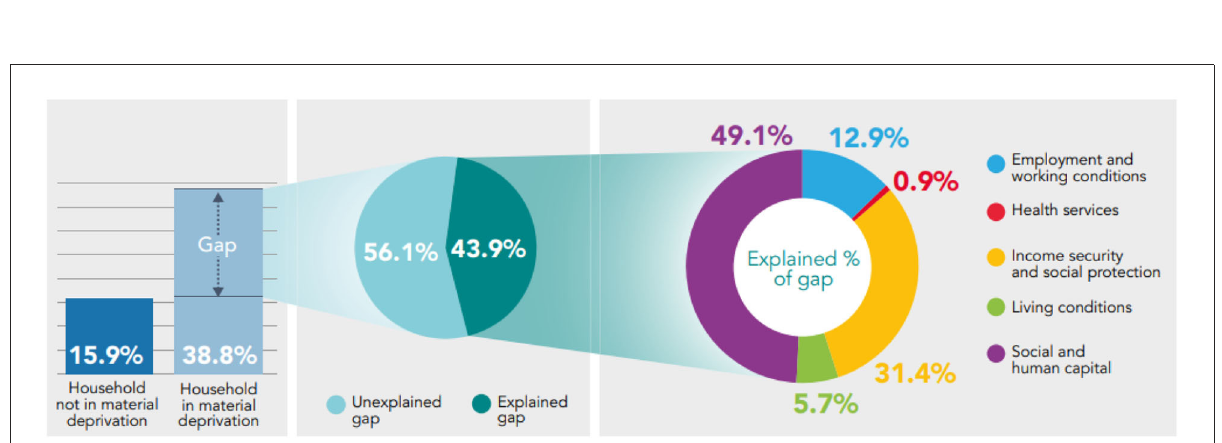
FIGURE5 Decomposing the gap in prevalence of low mental well-being between those who report being in material deprivation and those who do not using the Binder-Oaxaca methodology, persons aged 16 + , Wales, 2016–17 to 2019–20.